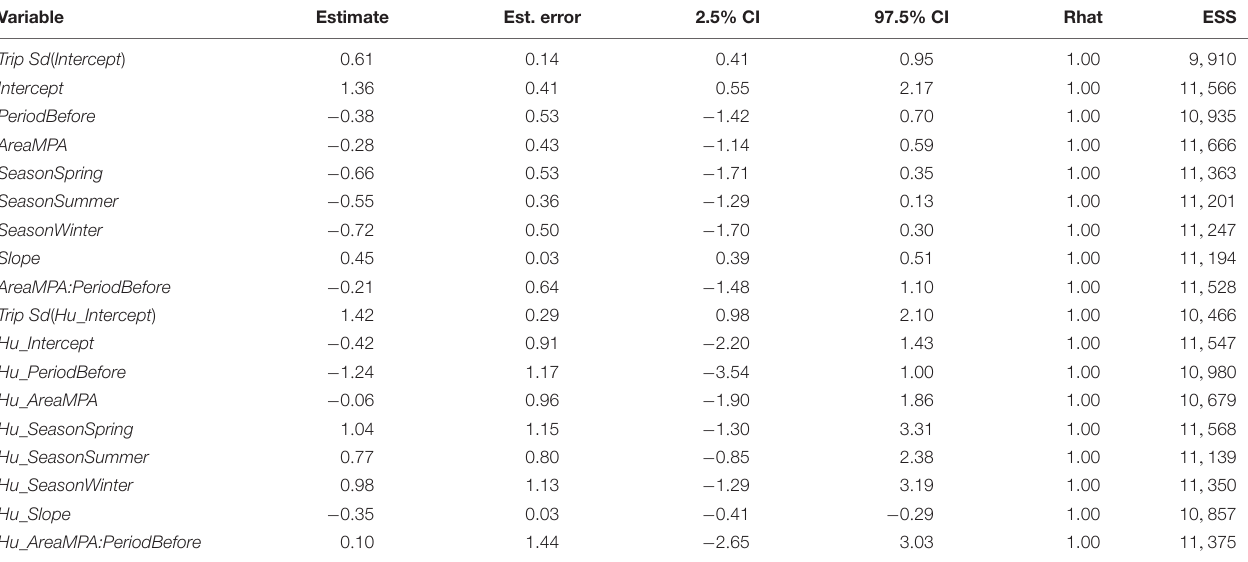
TABLE 5 | Results from the biomass model containing the full suite of predictor variables, which was competitive with the best model in terms of WAIC.